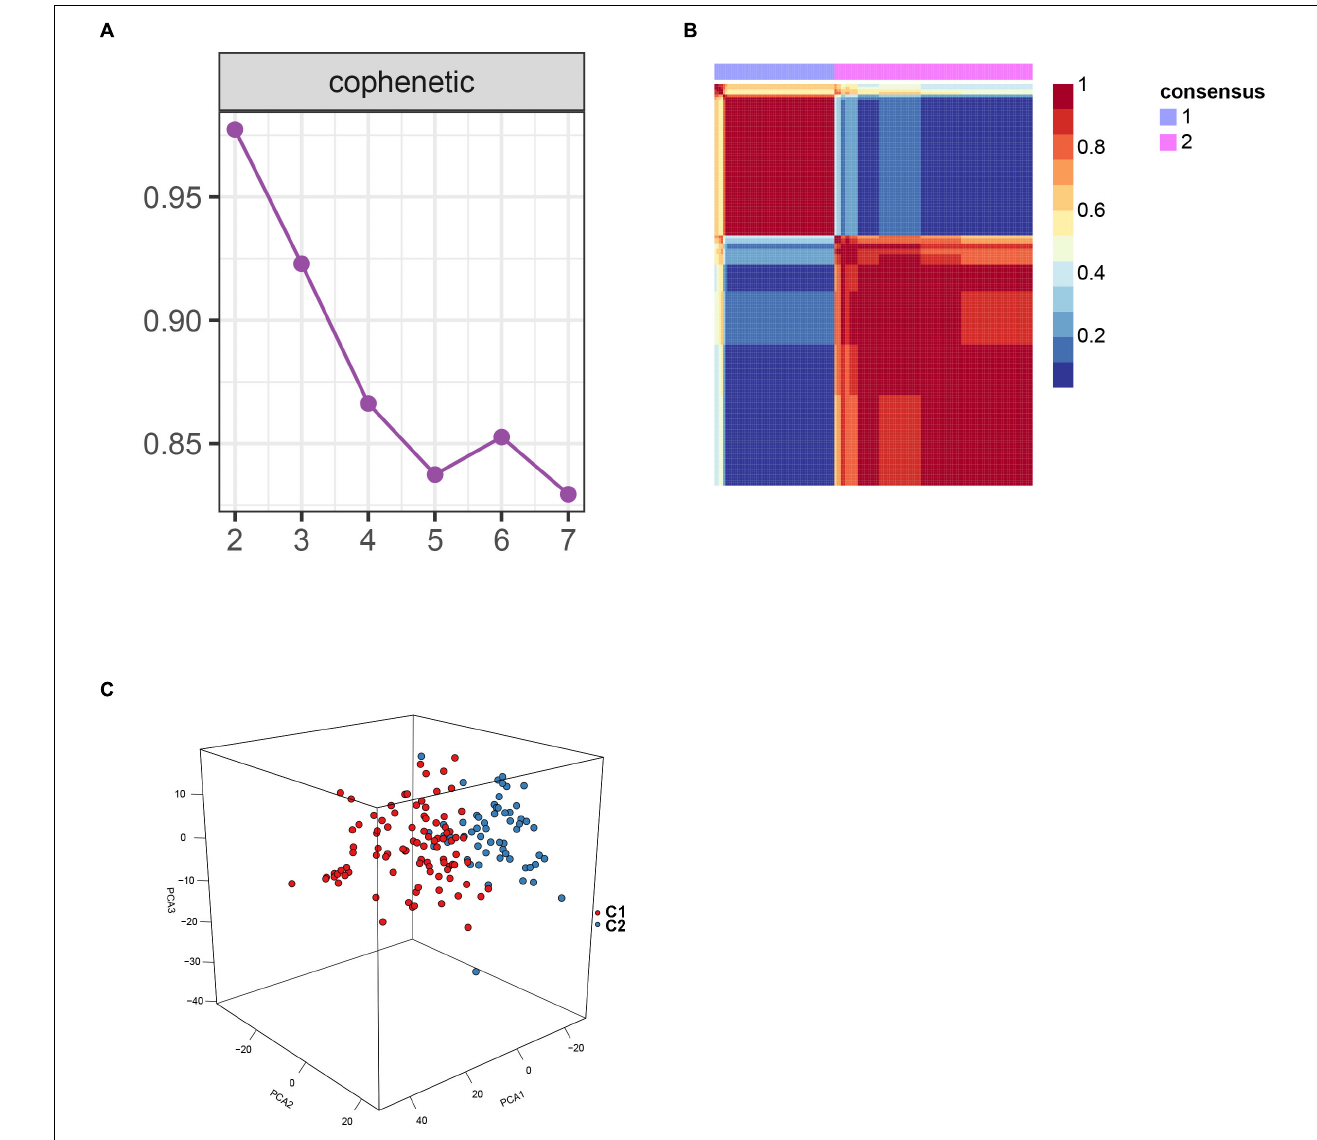
FIGURE 3 | Non-negative matrix factorization analysis for the merge dataset. (A) The cophenetic correlation coefficient was calculated for k = 2–7. (B) Non-negative matrix heatmap was plotted when k = 2. (C) Principal component analysis (PCA) supported the stratification when k = 2.